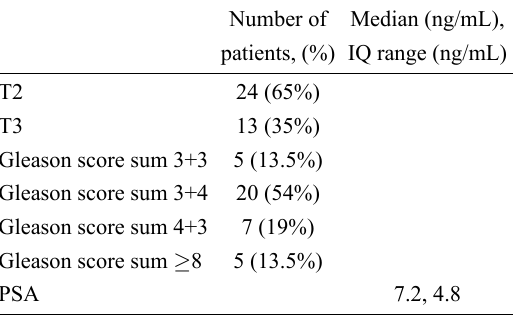
Table 1. Patients’